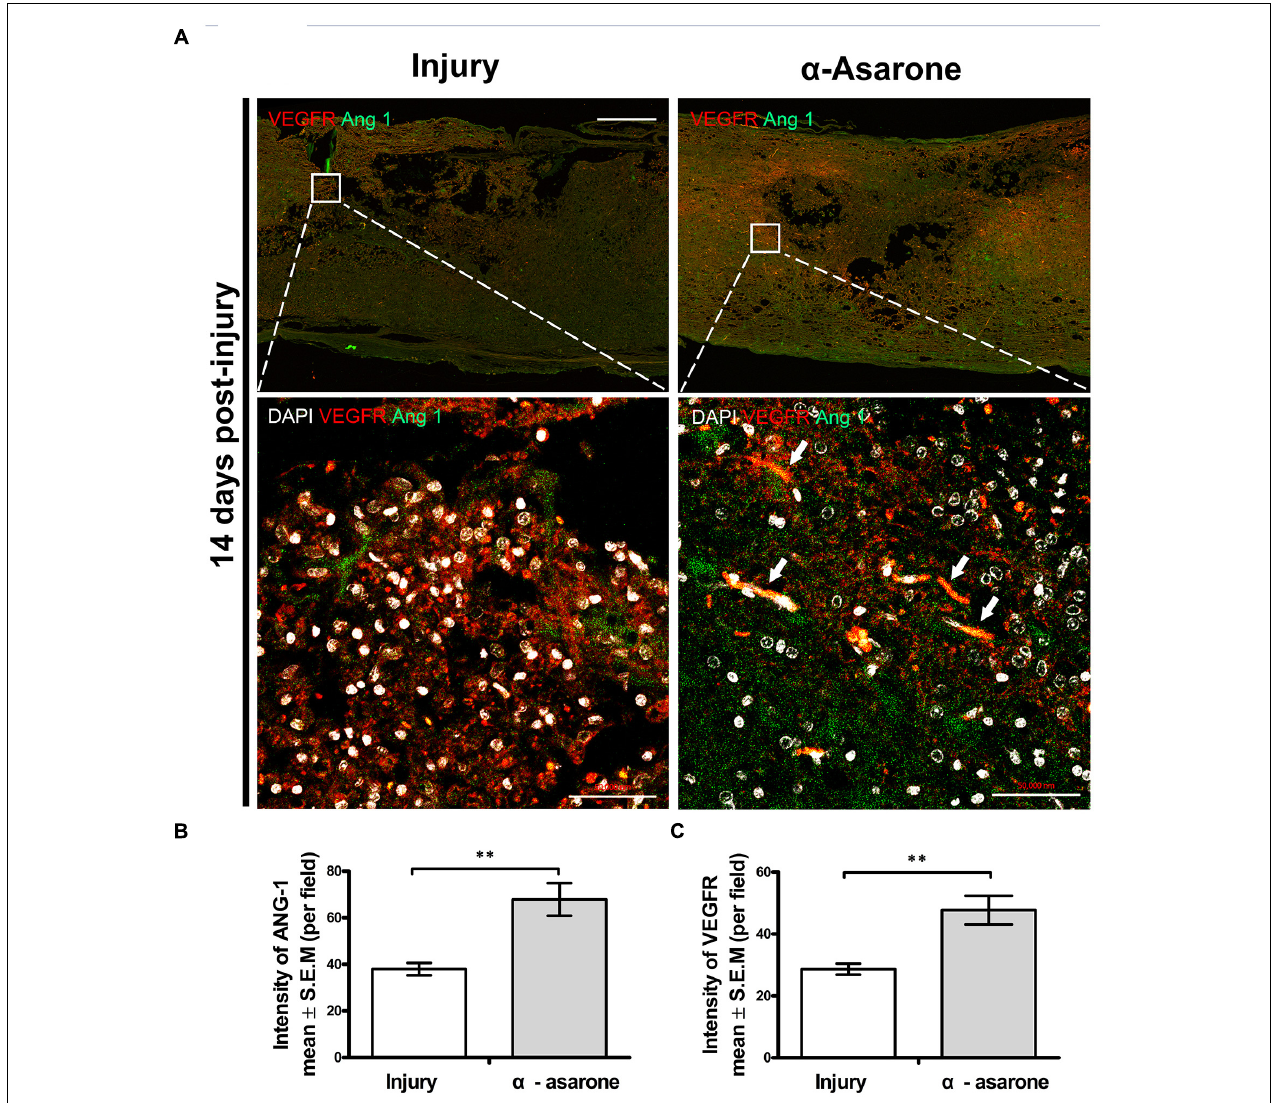
FIGURE 7 | α -asarone promoted angiogenesis in vivo . (A) Immunolabeling for vascular endothelial growth factor receptor (VEGFR; red, angiogenesis marker), Ang 1 (green, angiogenesis marker). DAPI is used for nuclear counterstaining at the site of the lesion. Scale bars, 5,000 µ m. (B,C) Quantitative analysis of immunohistochemistry for VEGFR, Ang 1. ∗∗ P < 0.01, one-tailed Student’s t -test ( n =